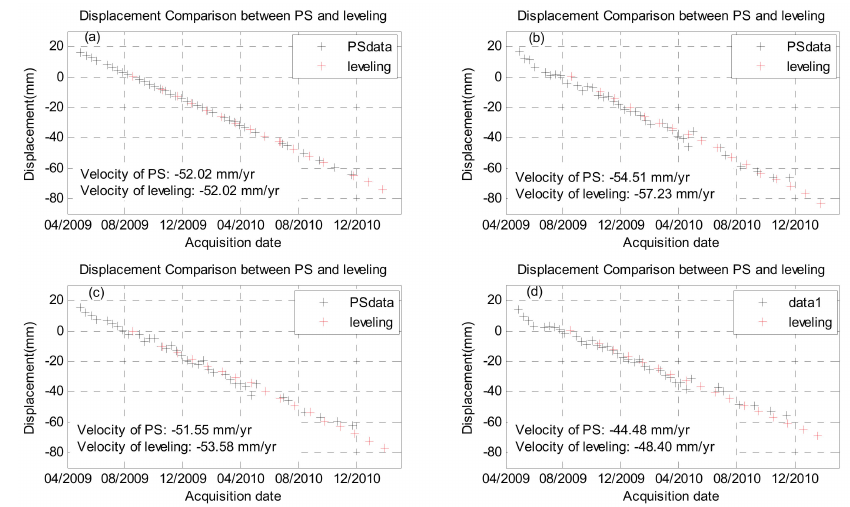
Figure 8. The displacement comparison along the vertical direction between PS results and leveling along Jingjin Inter-City railway line. The red crosses represent the displacements of leveling values while and black crosses represent that of PS results. ( a – d ) shows the comparison results at the points of ID3, ID16, ID29 and ID 40,